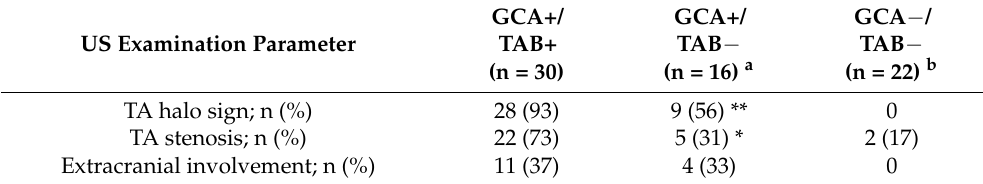
Table 2. Frequencies for each US measurement in each patient